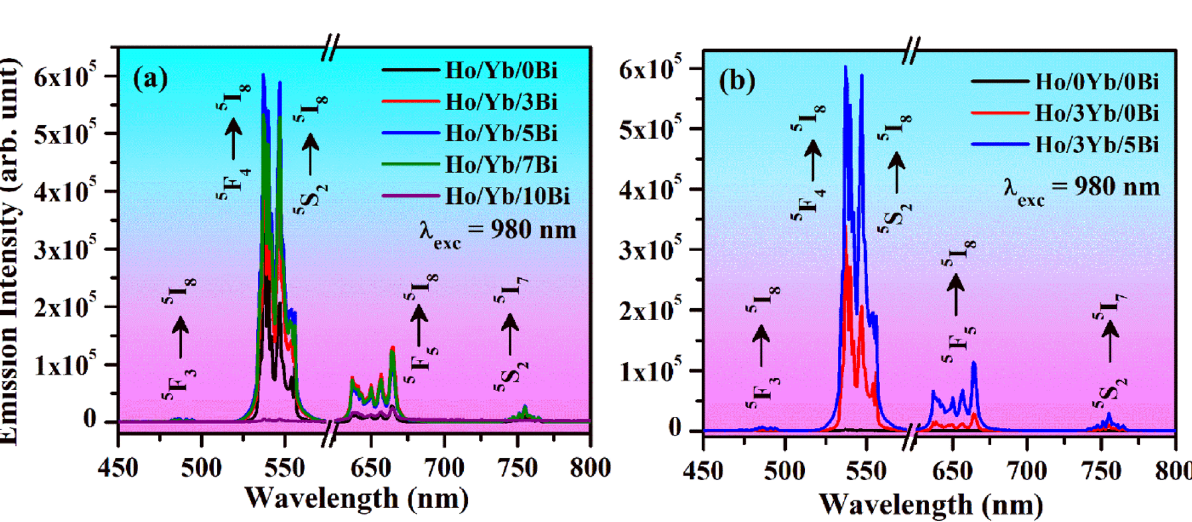
Figure 10. ( a ) The UC spectra of the Ho 3+ /Yb 3+ /xBi 3+ (i.e. x = 0, 3, 5, 7 and 10 mol%) co-doped phosphors monitored under 980 nm excitations at 31.84 W/cm 2 . ( b ) The comparison of UC emission intensities of Ho 3+ doped, Ho 3+ /Yb 3+ and Ho 3+ /Yb 3+ /5Bi 3+ co-doped phosphors monitored under 980 nm excitations at 31.84 W/ cm 2